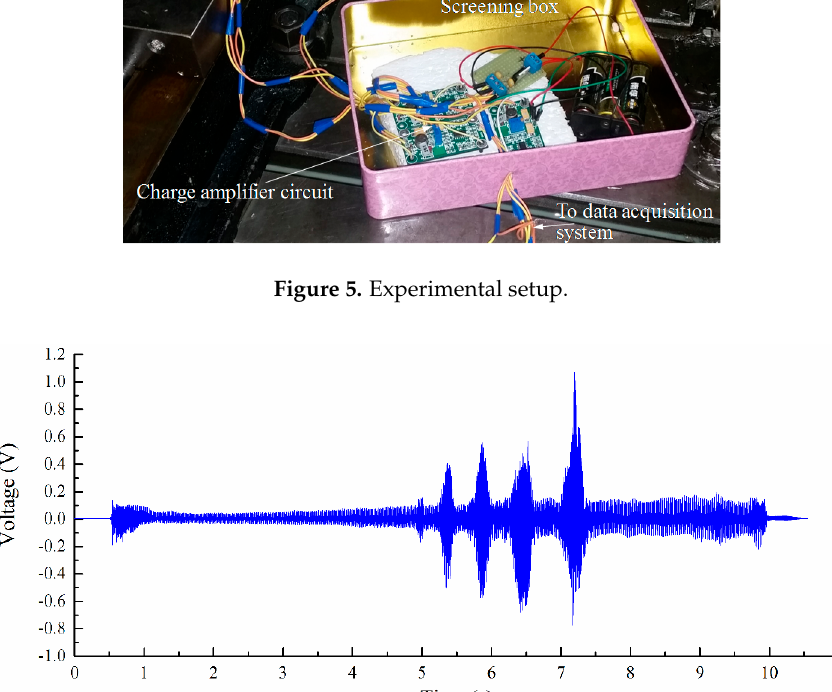
Figure 7. Initial cutting stage.